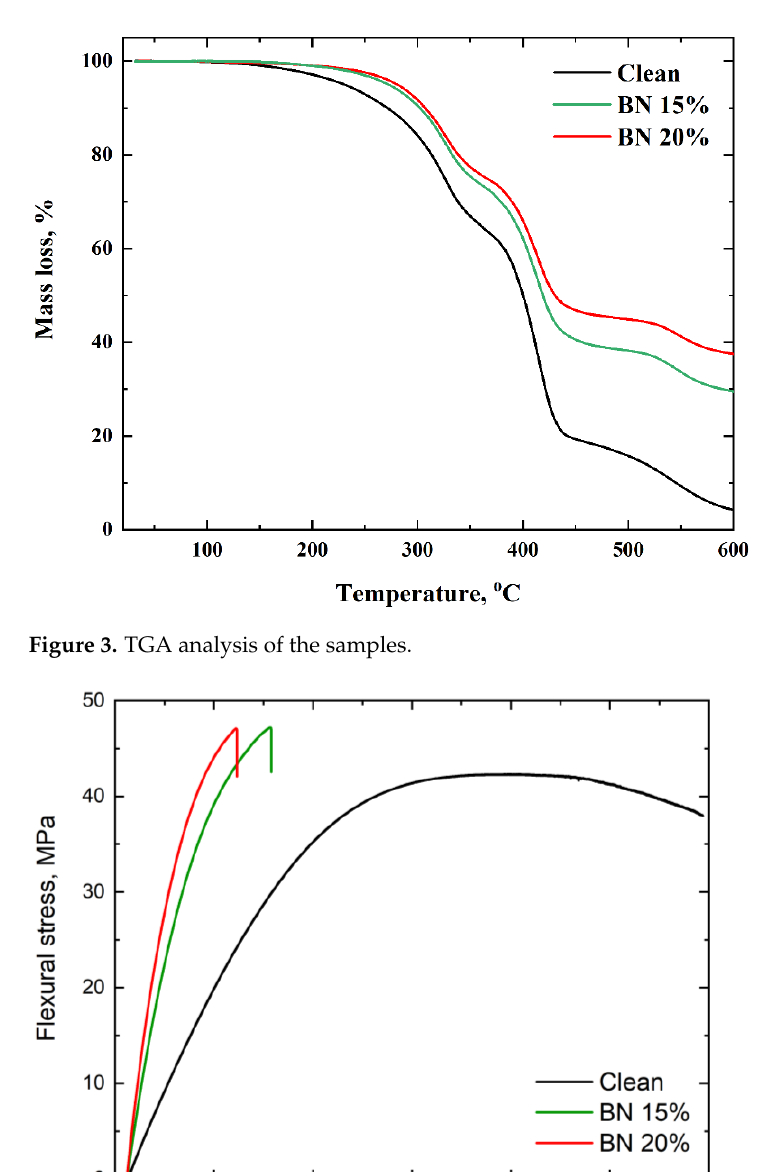
Figure 4. Flexural stress–strain curve for the clean polymer and the polymer composites with 15% and 20% BN.